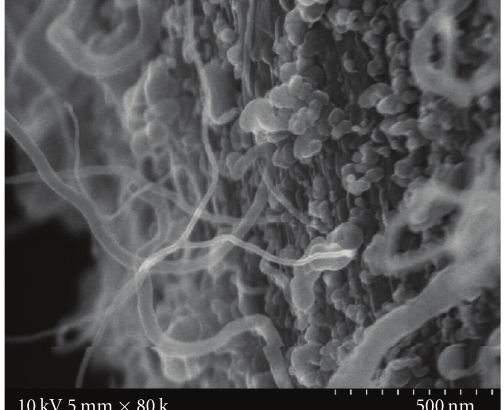
Figure 9: SEM image of CNTs grown on pitch carbon fiber. The continuous nature of the deposited catalyst film is not observed; instead, nanoscale particles or Fe/C compounds are observed.